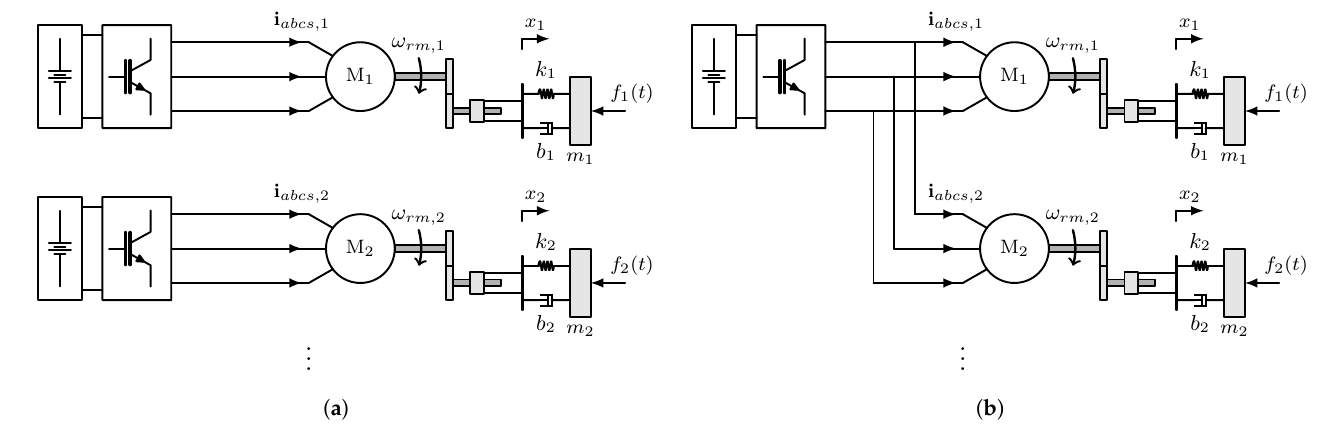
Figure 2. Notional depiction of DCMM ( a ) and CCMM ( b )